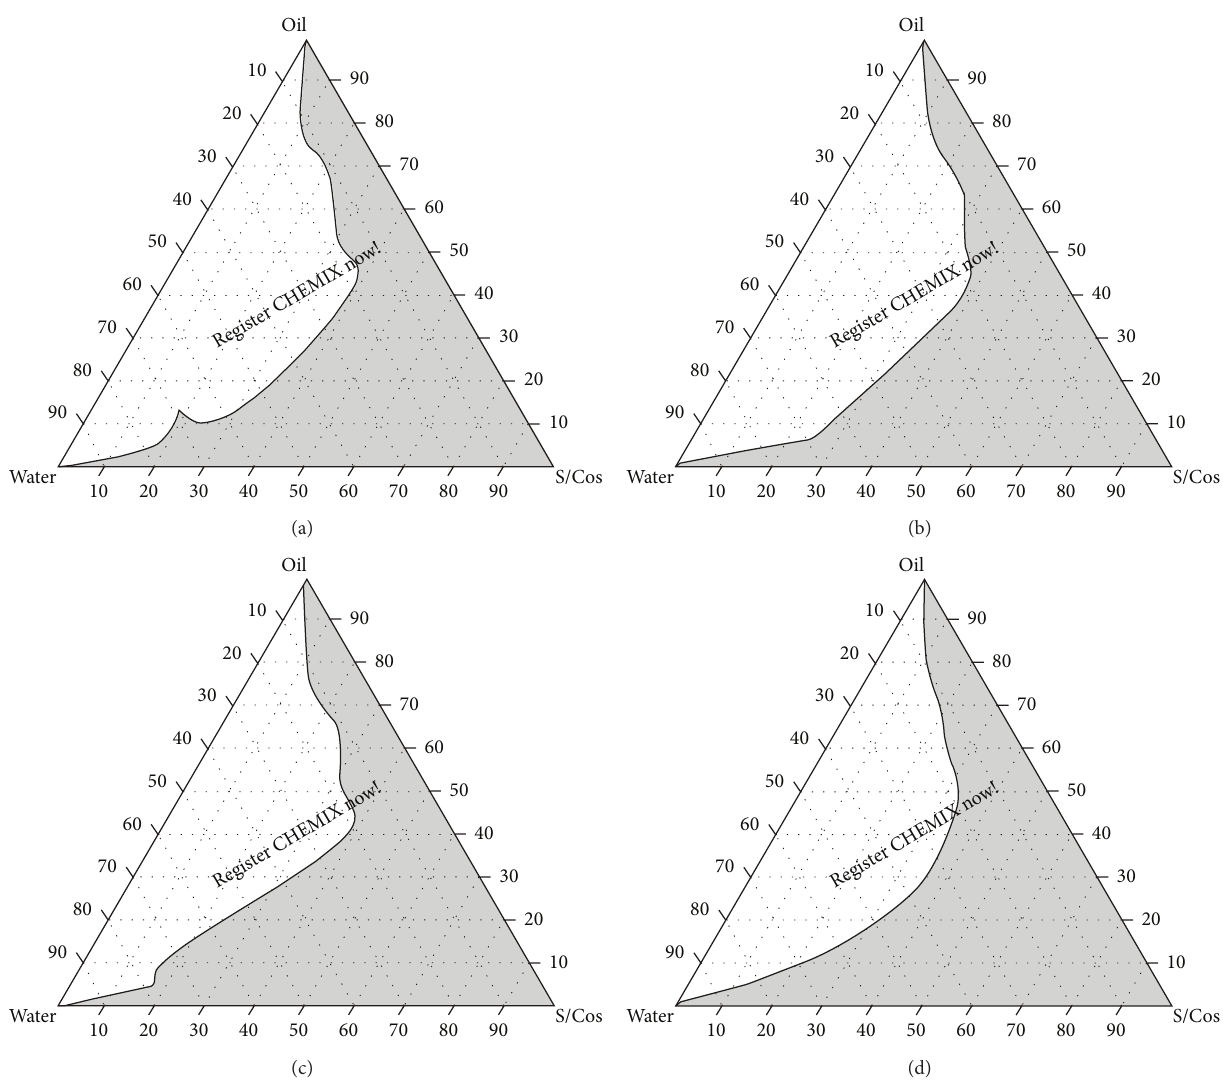
Figure 2: Pseudoternary phase diagrams with following components: oil = Capmul MCM, surfactant = Tween 80, and cosurfactant = Transcutol P. S/Cos ratio of A is 1:1, B is 2: 1, C is 3:1, and D is 4 :1. S/Cos indicates surfactant/cosurfactant. Area in grey shade indicates self-emulsifying